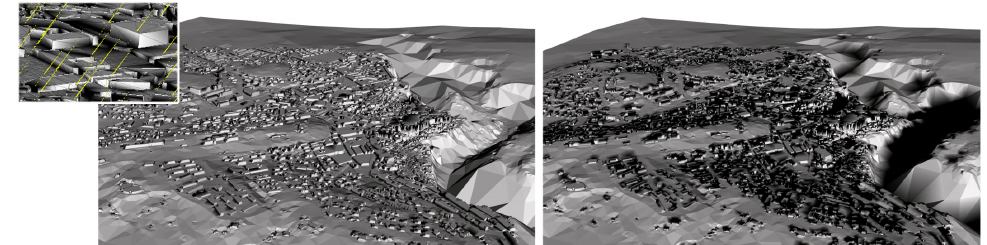
Figure 9. Solar illumination expected on 15 August ( left ) and 25 December ( right ) at the same time (9:00 a.m.). In the detail, some incident rays used in the